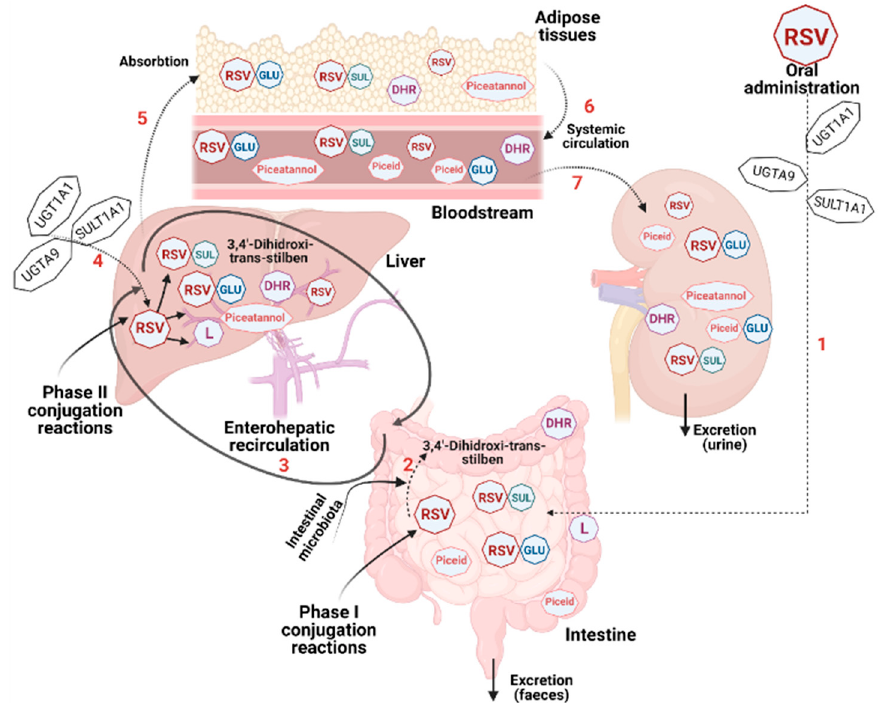
Figure 3. Overview of the biotransformation process of resveratrol in the human body. After oral administration, the parent molecule undergoes sulfation by SULT1A1 in the intestine and liver (RSV-SUL). Similarly, the enzymes UGT1A1 and UGTA9, expressed at intestinal and hepatic level, catalyze the formation of glucuronidated metabolites (RSV-GLU). Piceid, piceatannol, 3,4 ′ -dihydroxy- trans -stilbene, dihydroresveratrol (DHR) and 3,4 ′ -dihydroxybibenzyl (lunularin) (L) are obtained after the gut microbiome action on the ingested compound. Finally, the compounds are absorbed into the bloodstream and are subsequently eliminated from the body through urine or feces.